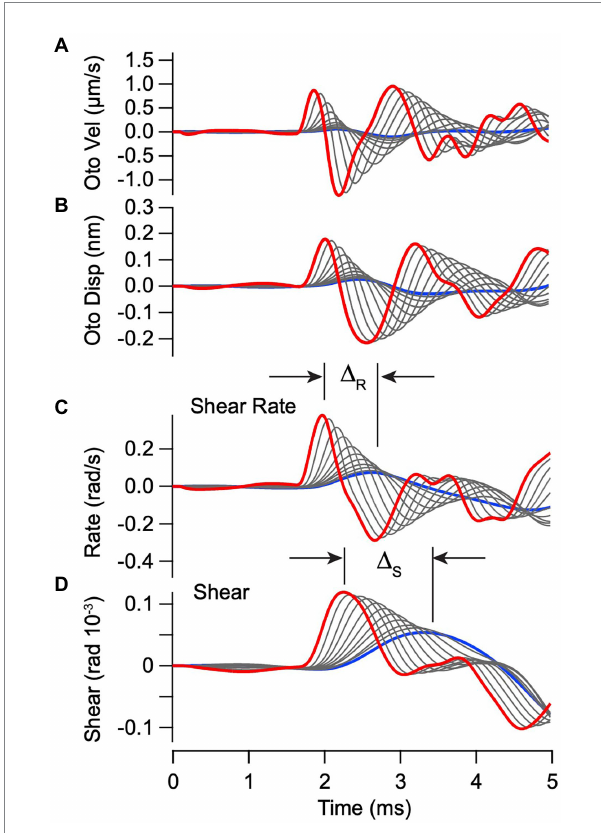
FIGURE 4 Simulated vibration of the otoconial layer for BCV. Individual curves use the same parameters and stimuli as Figure 3. (A,B) Otoconial layer velocity and displacement relative to the temporal bone. (C,D) Angular shear rate (radians/s) and shear (rad) between the otoconial layer and the epithelial surface (macula), which reflects angular deflection and the rate of angular deflection of the hair bundles. Δ is the delay between peak shear rate (C) and peak shear (D) in response to the highest vs. the lowest strength BCV